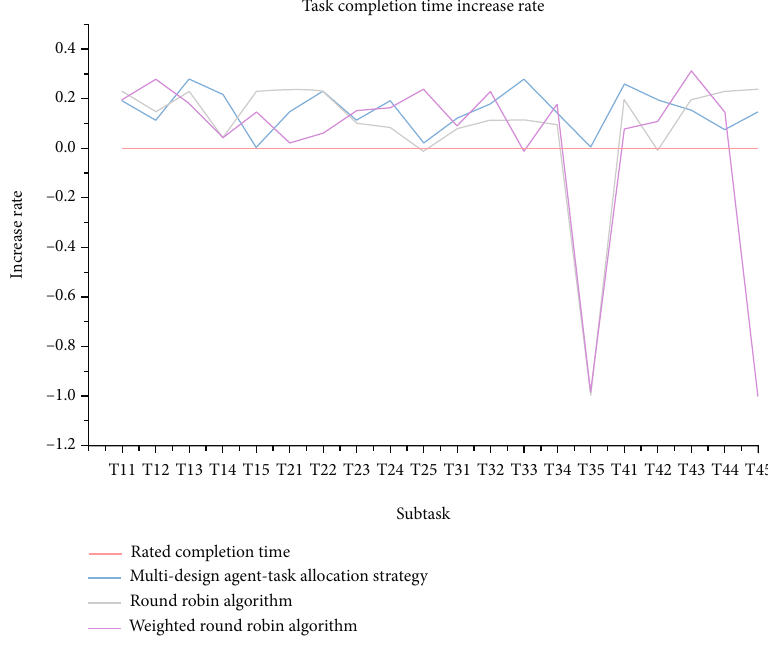
Figure 4: Task completion time comparison chart.